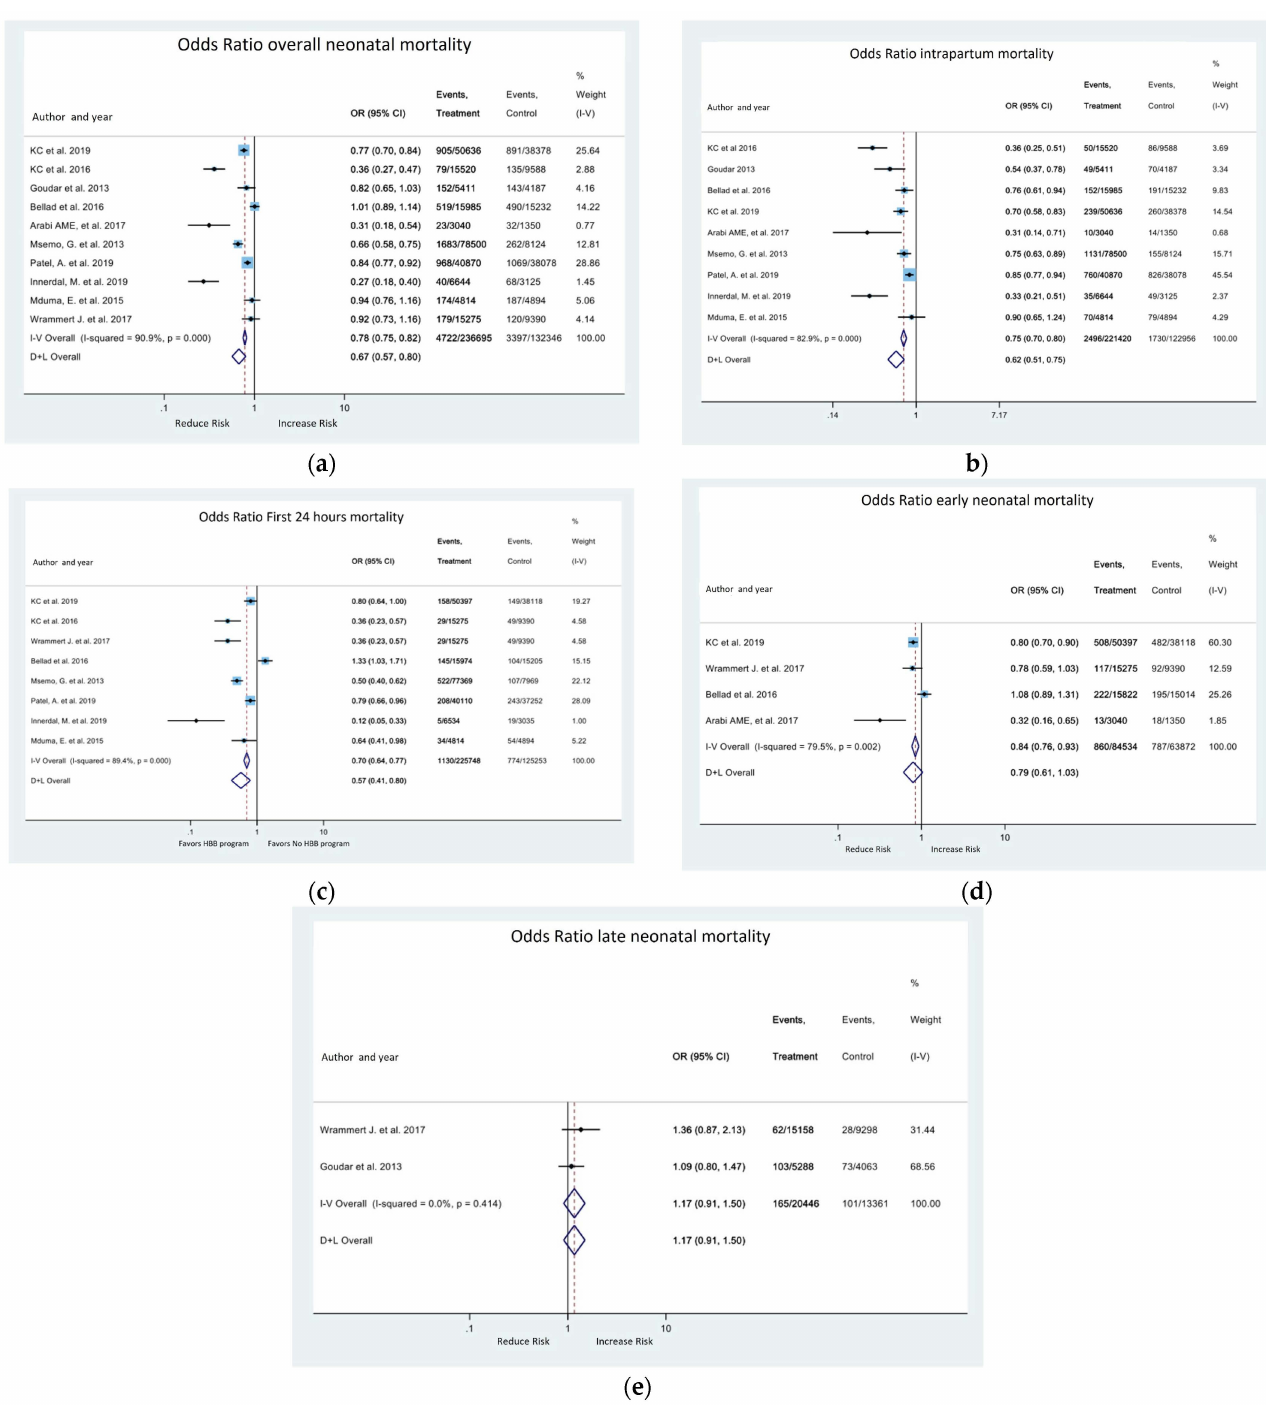
Figure 2. Forest plot for the effect of HBB program on neonatal mortality; ( a ) overall neonatal mortality; ( b ) intrapartum stillbirth mortality; ( c ) first-day neonatal mortality; ( d ) first week (early) neonatal mortality; ( e ) late neonatal